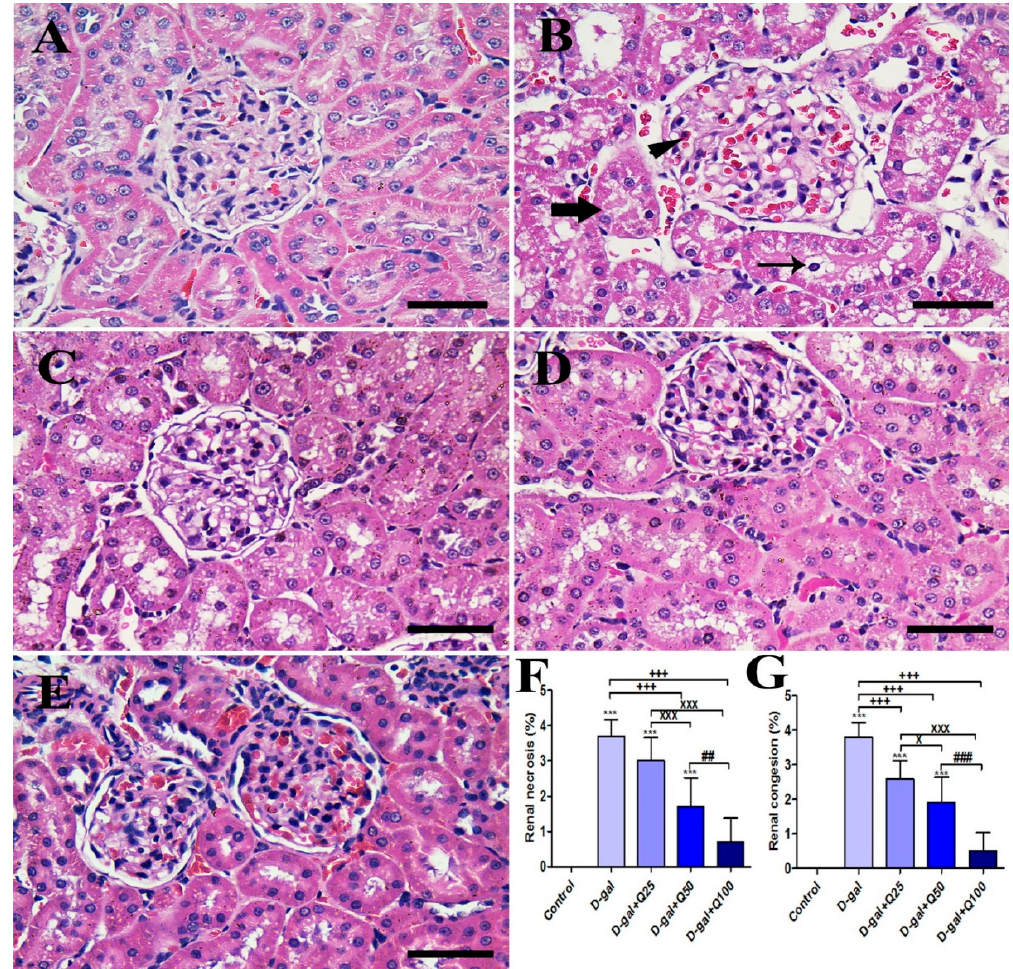
Figure 7. Histopathological examination of rats’ kidney. ( A ) Negative control group. ( B ) D-gal group revealing congestion (arrowhead), degeneration in the renal tubules (thin arrow), and intratubular eosinophilic proteinaceous materials inside the lumen of renal tubules (thick arrow). ( C ) Gal-Q25 group. ( D ) D-gal + Q50 group. ( E ) D-gal + Q100 group. ( F ) H&E semiquantitative scoring of renal necrosis. ( G ) H&E semiquantitative scoring of renal congestion. Scale bar = 50 µ m. Data were analyzed with one-way ANOVA followed by Tukey’s multiple comparison test. Error bars represent mean ±